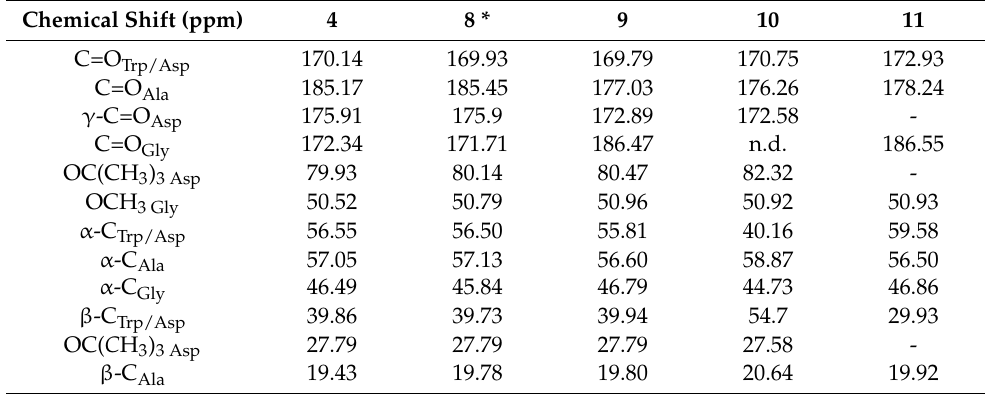
Table 3. Assigned 13 C-NMR resonances for complexes 4 , 8 – 11